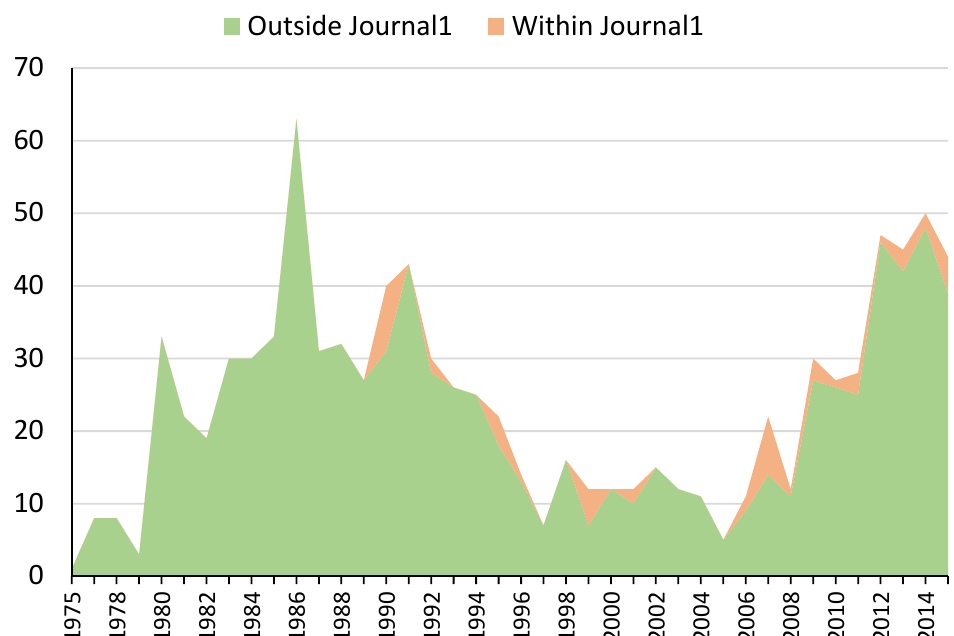
Figure 5. Citations of Author4’s papers in WoS distinguishing between citations of Author4’s papers, wherever published, whether cited or not in Journal1.